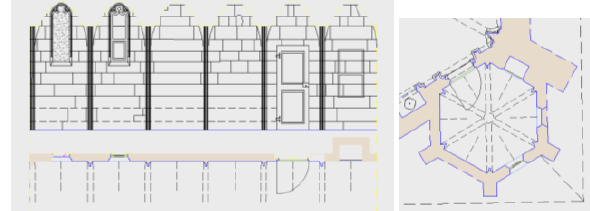
Figure 4. Graphic develop of NW sacrestia for the representation of stone blocks distribution.